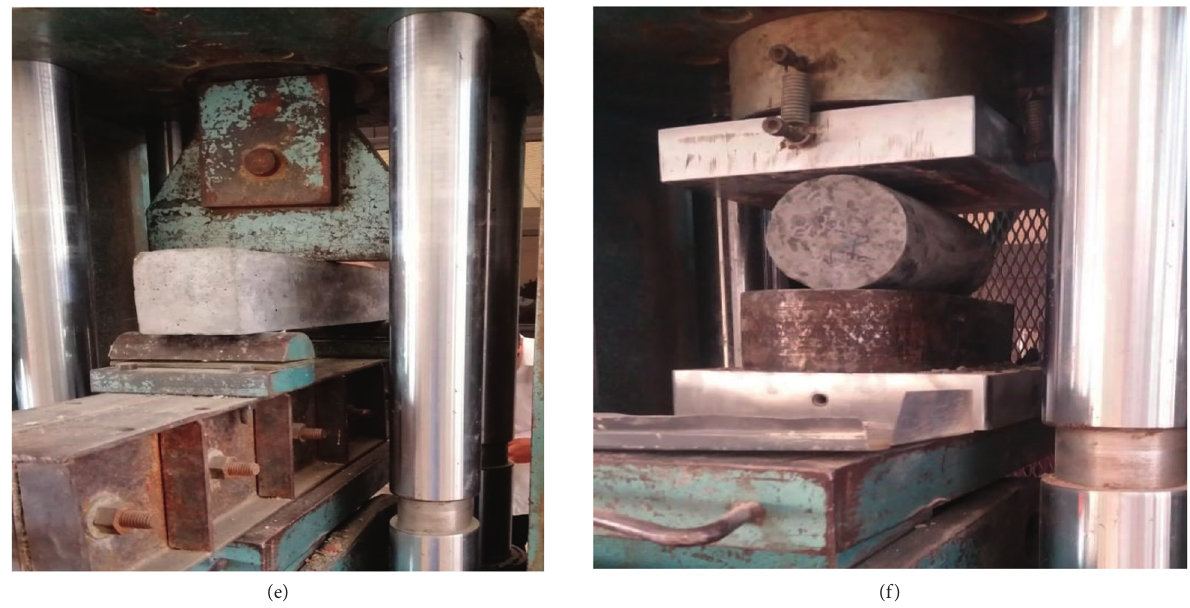
Figure 3: Experimental setup of concrete testing. (a) Slump test. (b) Water absorption test setup. (c) Water curing tank. (d) Compressive strength test. (e) Flexural strength test. (f) Splitting tensile strength test.